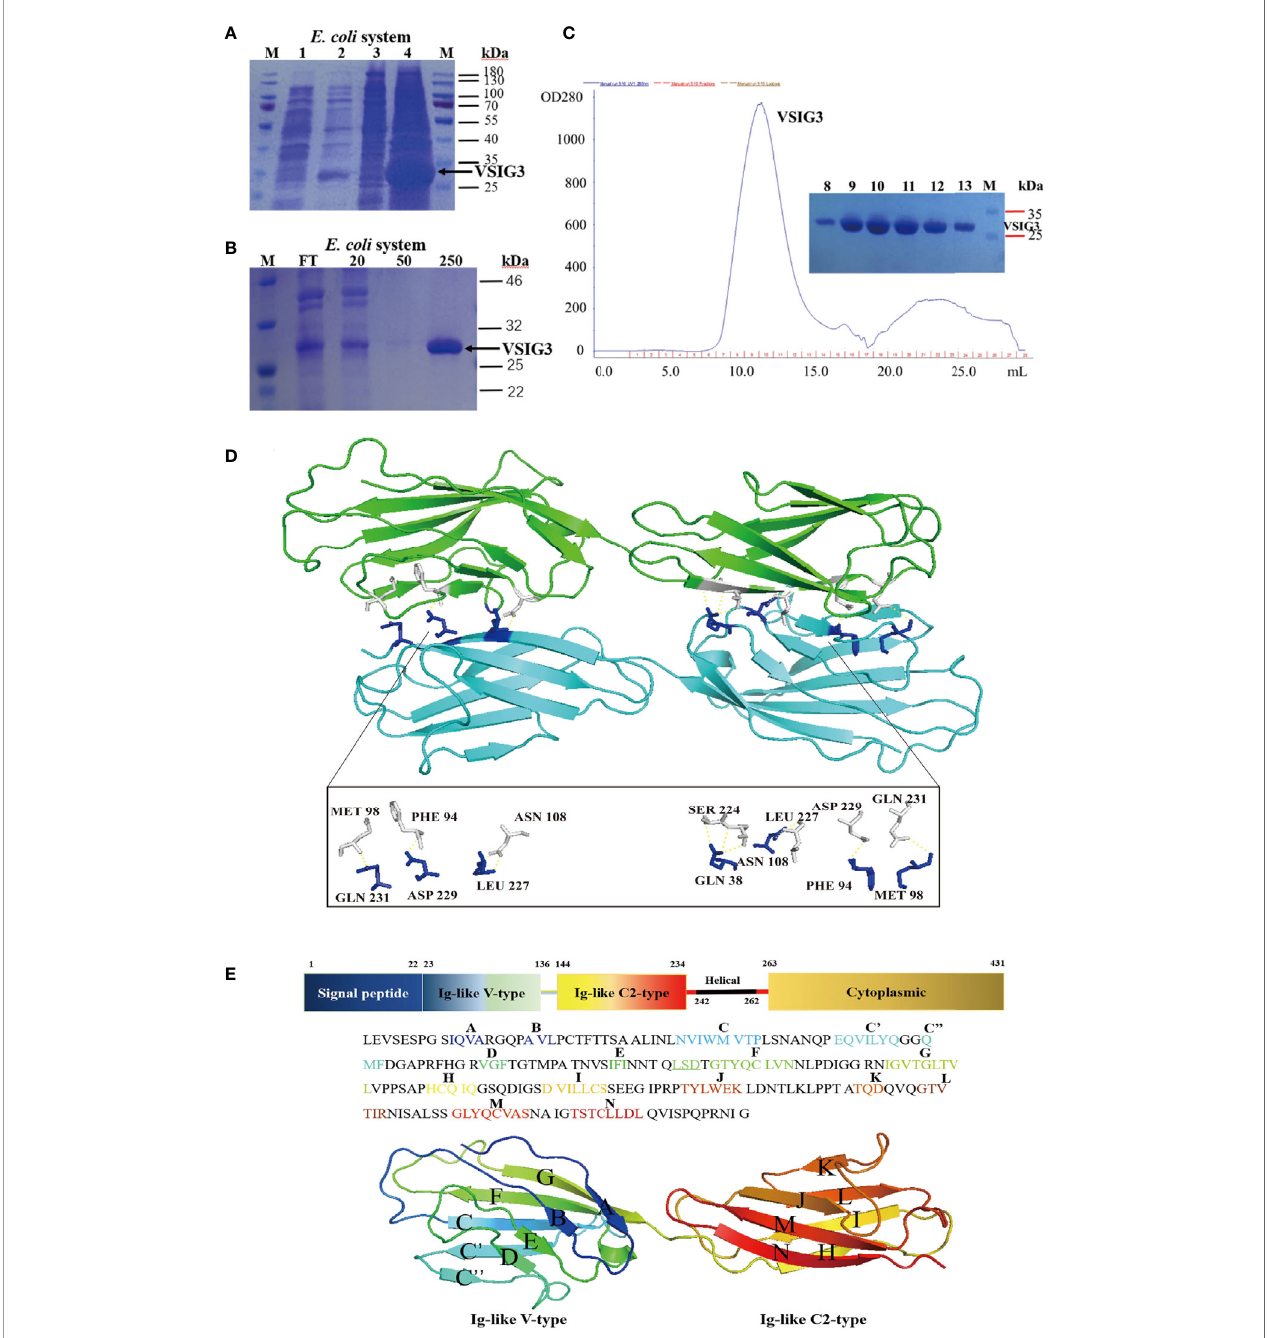
FIGURE 1 | The crystal structure of VSIG3 protein. (A) Coomassie blue staining results of E. coli expressed VSIG3 protein. (1: before IPTG induction; 2: after IPTG induction; 3: supernatant after lysis; 4: inclusion bodies). (B) The VSIG3 protein was eluted with different concentrations of imidazole solutions (20 mM, 50 mM, 250 mM). FT: Flow through solutions. (C) Puri fi cation of refolded VSIG3 protein by size exclusion chromatography on Superdex 75. (D) Overview of the human VSIG3- ECD protein crystal structure as a dimer. Protein monomers interact with each other by hydrogen bonding. Chain A (green), chain B (cyan). (E) Detail of the structure of VSIG3-ECD protein. Sequence of human VSIG3-ECD with labeled secondary structure. Cartoon structure of human VSIG3-ECD with labeled secondary